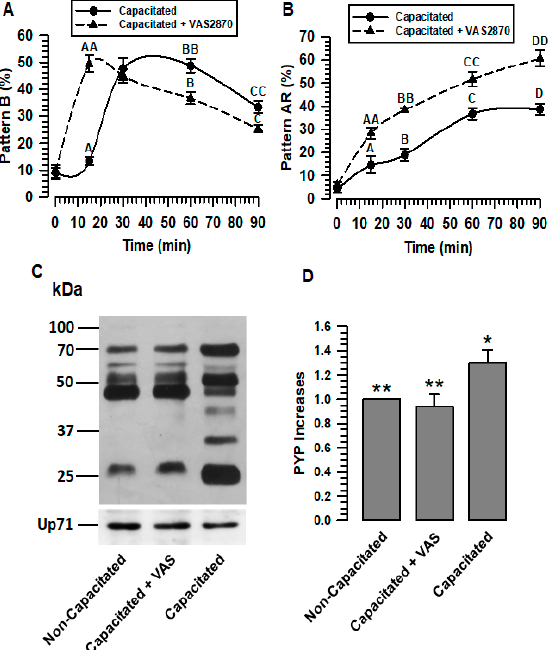
Figure 3. The activity of sperm NOXs is important for capacitation and acrosomal reactions. The role of NOX in guinea pig sperm physiology was defined by incubating them under capacitating conditions for 60 min, either in the absence or presence of VAS (VAS2870 40 µM). Capacitation was evaluated by CTC techniques, and protein tyrosine phosphorylation patterns (PYP) were deter- mined by immunoblotting using a specific anti-p-Y antibody. ( A ) Assessment of pattern B by CTC. ( B ) Evaluation of the A.R. pattern by CTC. ( C ) Determination of PYP increases by immunoblotting in non-capacitated or capacitated spermatozoa in the absence and presence of VAS (VAS2870 40 µM). Up71 was used as a loading control. The representative Wb image of three independent experiments for PYP is shown. ( D ) Densitometric assessment of PYP. The results are expressed as the ratio N/N0, where N is the total amount of PYP and N0 is the total PYP quantity of non-capacitated. Results are expressed as the mean ± S.E. ( n = 3). Differences were considered significant when p ≤ 0.05, comparing (*) concerning (**).